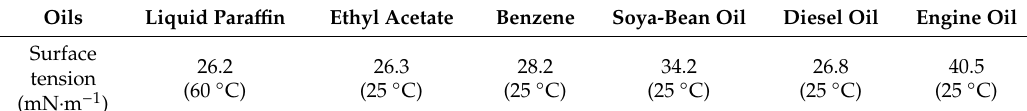
Table 1. The surface tension values of oils.